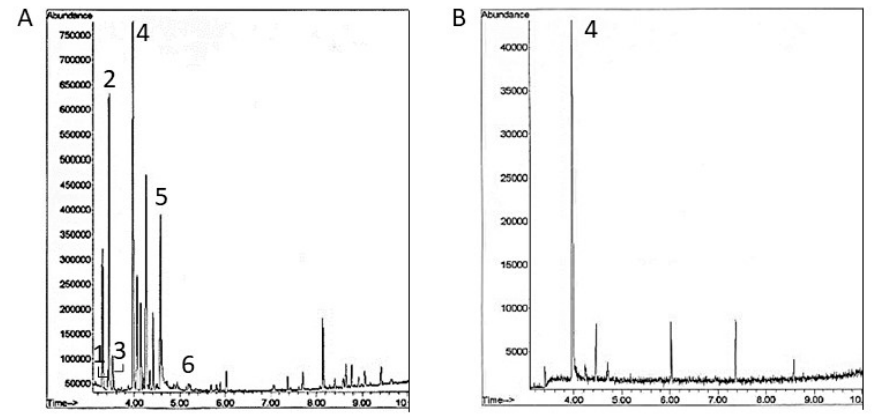
Figure 4. Examples of GC-MS runs (first 10 min of the 20 min run shown) for ( A ) the crude alkaloid fraction and ( B ) purified 1,6-dehydropinidine fraction. Numbers 1-6 refers to 2-methyl-6-propyl-1,6- piperideine, epidihydropinidine, trans -pinidine, 1,6-dehydropinidine, epipinidinone + cis -pinidinol, and, tentative, 1,6-dehydropinidinone, respectively. Other peaks are monoterpene and simple alkane impurities and were not quantified.